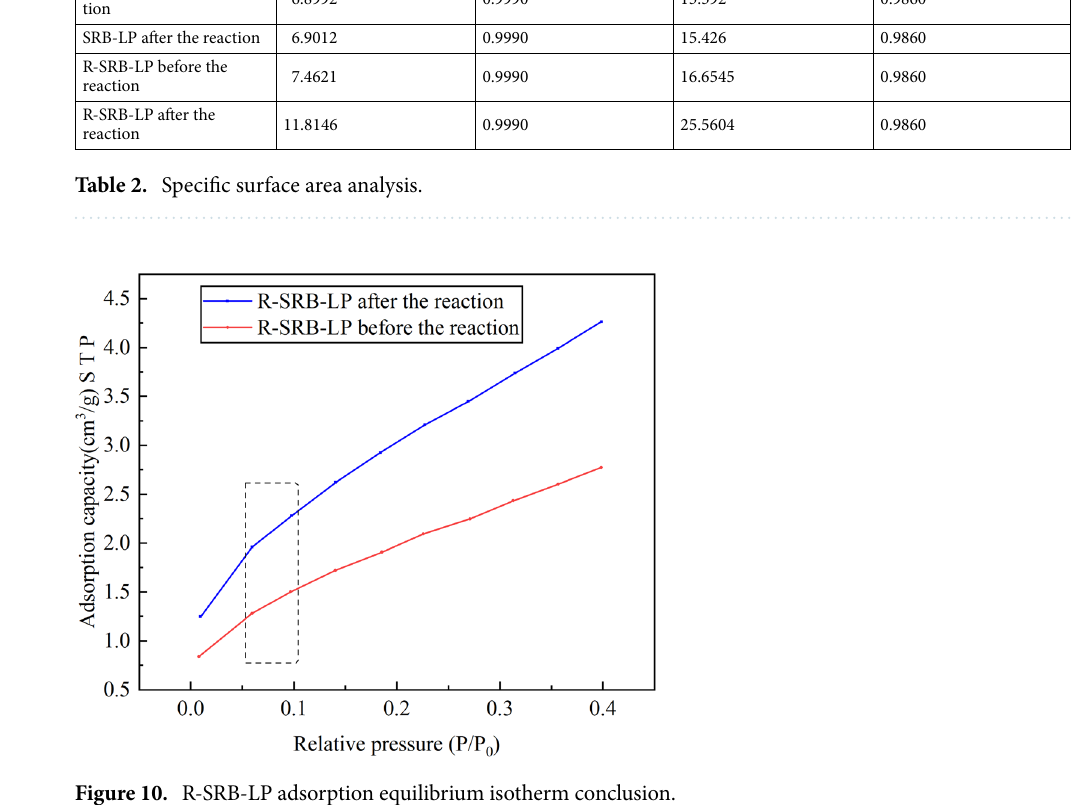
Figure 10. R-SRB-LP adsorption equilibrium isotherm